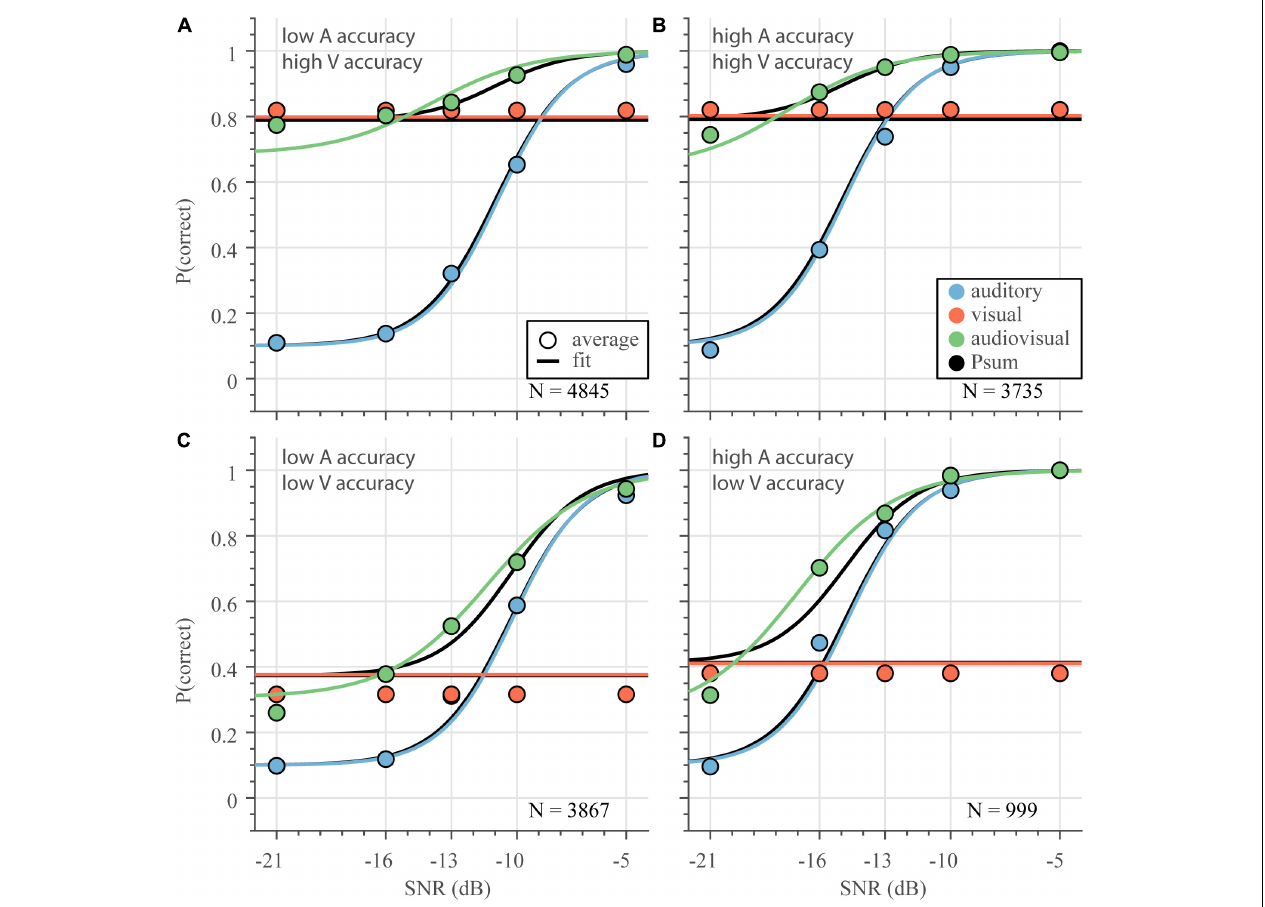
FIGURE 6 | Audiovisual speech recognition varies with unimodal information. Psychometric curves were determined (equation 1–3) from all data divided across 4 groups differing in unimodal performances: visual recognition rate (A,B) larger and (C,D) smaller than 0.55 ; and an auditory recognition rate (A,C) larger than and (B,D) smaller than 0.55. Curves indicate the average model estimate, circles denote the average correct score. N is the number of subject-word-SNR combinations for each